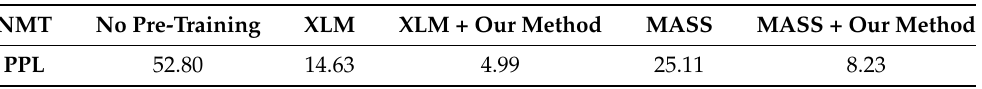
Table 5. The word translation results of neural machine translation (NMT) models initialized by different pre-training models on each test